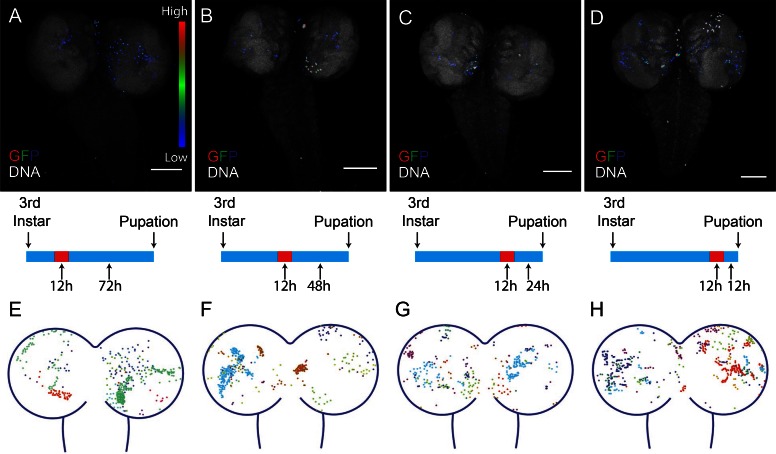
Timing of CasExpress activation in larval CNS.Larvae with CasExpress G-Trace and Gal80ts were grown in 18°C (blue bars in the middle) until 3rd instar and shifted to 29°C for 12 hr. Then larvae were kept at 18°C for 72 hr (A, E), 48 hr (B, F), 24 hr (C, G) or 12 hr (D, H) until they reached late 3rd instar. (A–D) Four examples of GFP expression patterns in the larval CNS presented in Rainbow RGB, which shows different levels of GFP intensity in different colors. (E–H) Z-projections of different samples were slightly transformed and fit into the diagram of brain. The positions of GFP positive cells for each sample are indicated with different colors. Scale bars are 100 μm.